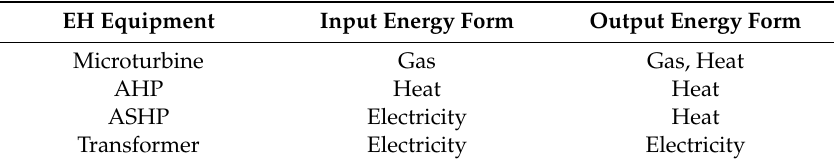
Table 1. Energy conversion of components in energy hub.